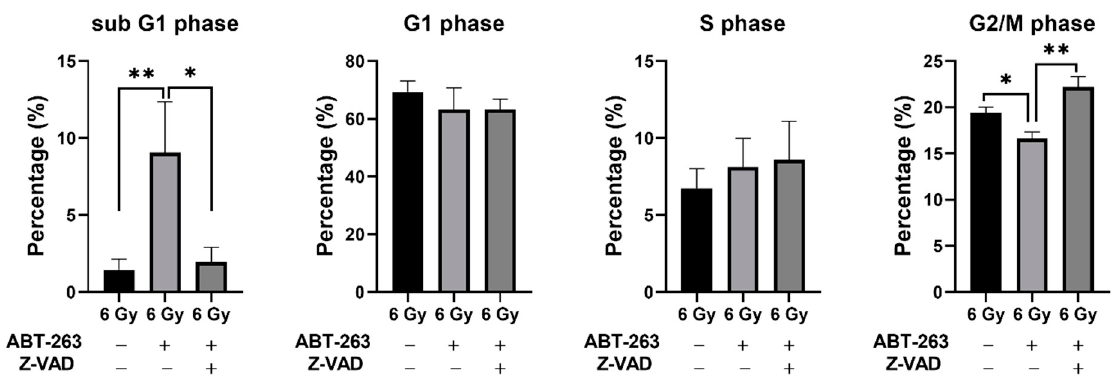
Figure 8. Effect of the caspase inhibitor Z-VAD on changes in the cell cycle distribution of irradiated A549 cells by ABT-263. A549 cells irradiated at 6 Gy were cultured for 24 h prior to the addition of ABT-263 (5 µ M) to the culture. Z-VAD was added to the culture 1 h before ABT-263 administration. After 48 h of culture, the adherent cells were harvested for cell cycle analysis. The percentages of each population are shown. Data are presented as the mean ± SD of independent experiments. * p < 0.05, ** p < 0.01.